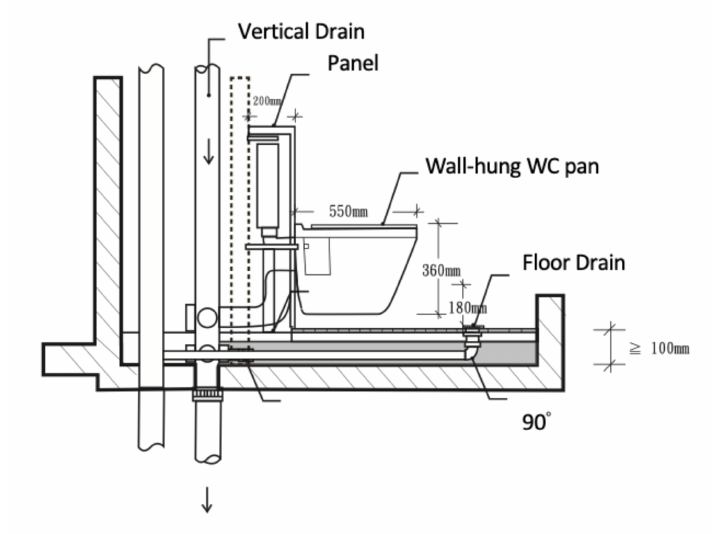
Figure 4. Schematic definition of the pre-wall piping